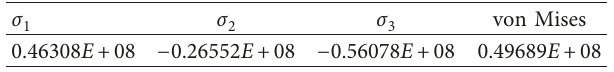
Table 5: The maximum principal stress and maximum von Mises stress of the narrow girder in air outlet side (Pa).